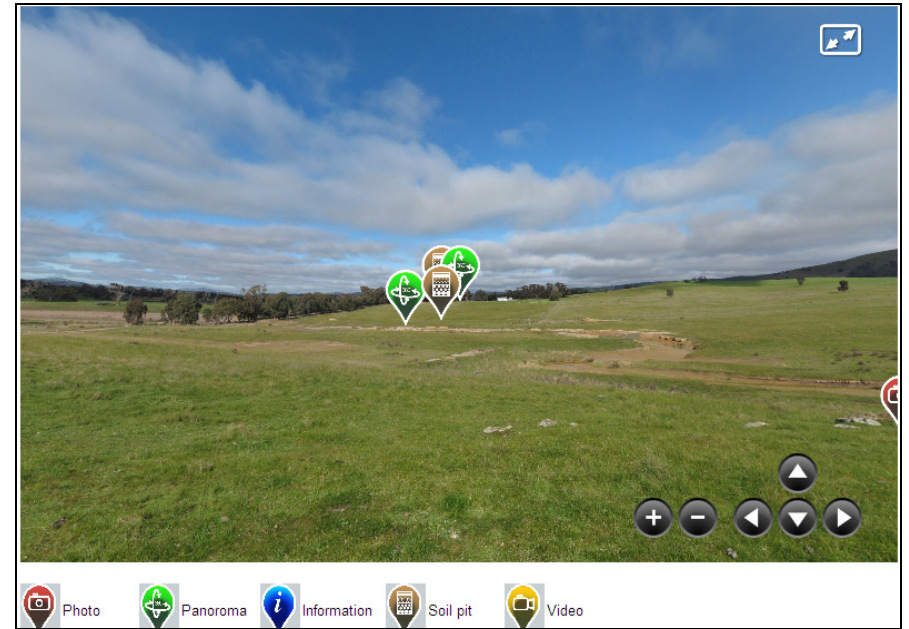
Figure 18. Interactive landscape panorama.  State of Victoria, Department of Primary Industries 1997 Reproduced with permission. From: http://www.dpi.vic.gov.au/dpi/vro/